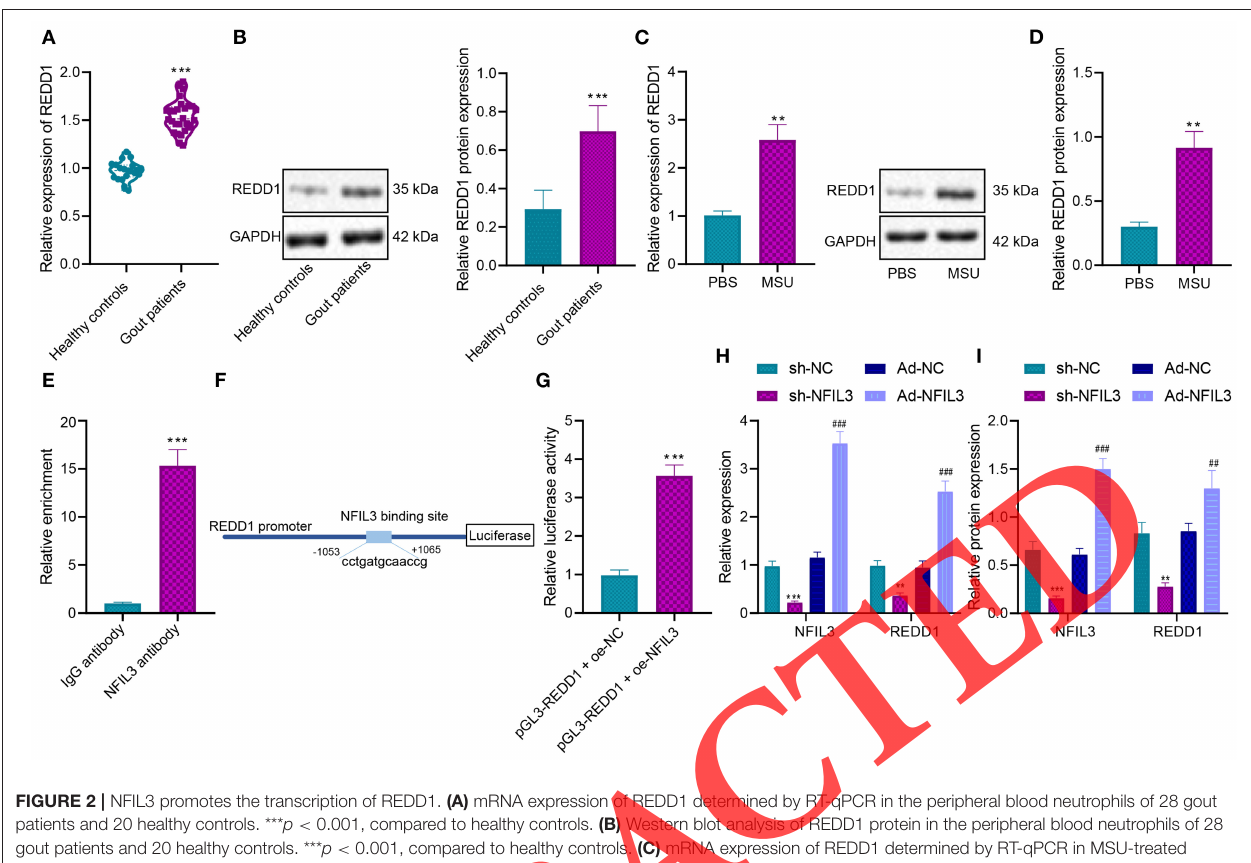
FIGURE 2 | NFIL3 promotes the transcription of REDD1. (A) mRNA expression of REDD1 determined by RT-qPCR in the peripheral blood neutrophils of 28 gout patients and 20 healthy controls. *** p < 0.001, compared to healthy controls. (B) Western blot analysis of REDD1 protein in the peripheral blood neutrophils of 28 gout patients and 20 healthy controls. *** p < 0.001, compared to healthy controls. (C) mRNA expression of REDD1 determined by RT-qPCR in MSU-treated neutrophils. ** p < 0.01, compared to PBS-treated neutrophils. (D) Western blot analysis of REDD1 protein in MSU-treated neutrophils. ** p < 0.01, compared to PBS-treated neutrophils. (E) The enrichment of NFIL3 in the REDD1 promoter region detected by ChIP assay. ** p < 0.01, compared to IgG antibody. (F) A schematic diagram of NFIL3 binding sites in the REDD1 promoter region. (G) Binding of NFIL3 to the REDD1 promoter analyzed by dual-luciferase reporter assay. *** p < 0.001, compared to cells treated with pGL3-REDD1 + oe-NC. (H) mRNA expression of NFIL3 and REDD1 determined by RT-qPCR in neutrophils following NFIL3 silencing or overexpression. ** p < 0.01 or *** p < 0.001, compared to cells treated with sh-NC. ### p < 0.001, compared to cells treated with Ad-NC. (I) Western blot analysis of NFIL3 and REDD1 proteins in neutrophils following NFIL3 silencing or overexpression. ** p < 0.01 or *** p < 0.001, compared to cells treated with sh-NC. ## p < 0.01 or ### p < 0.001, compared to cells treated with Ad-NC. Data are shown as mean ± standard deviation of three technical replicates. Data between two groups were compared using unpaired t -test while those among multiple groups were assessed by one-way